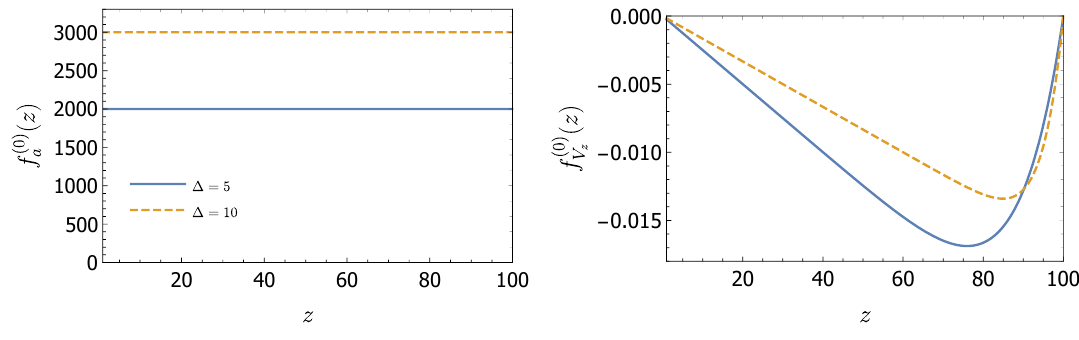
Figure 1 . Normalised massless zero mode pro(cid:12)les (3.5) with k = 1, kz UV = 1, kz IR = 100, p g 5 k = 1, and (cid:27) 0 = 0 :